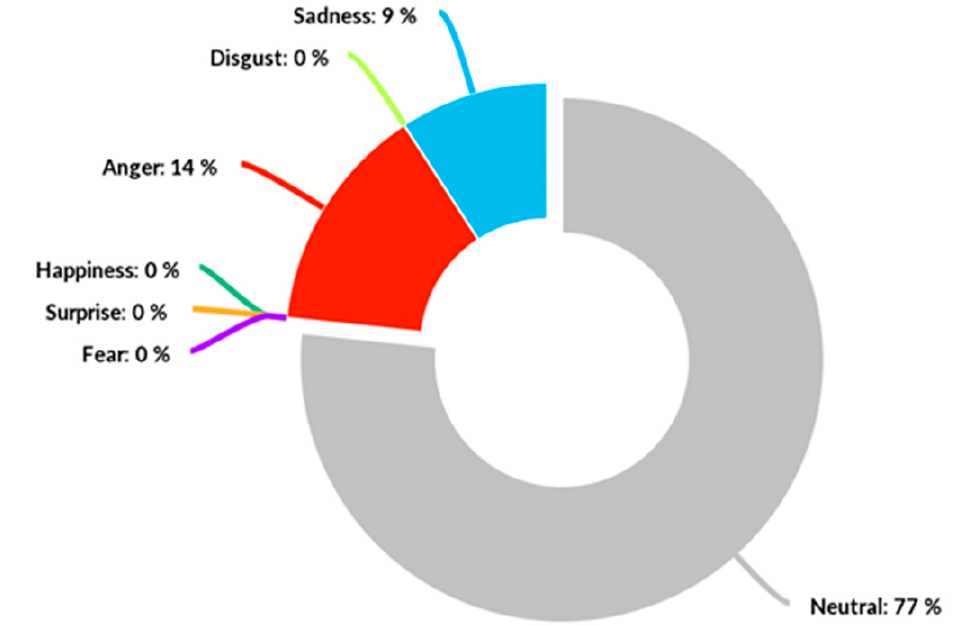
Figure 13. Collective emotions pie chart of users while performing task 2.